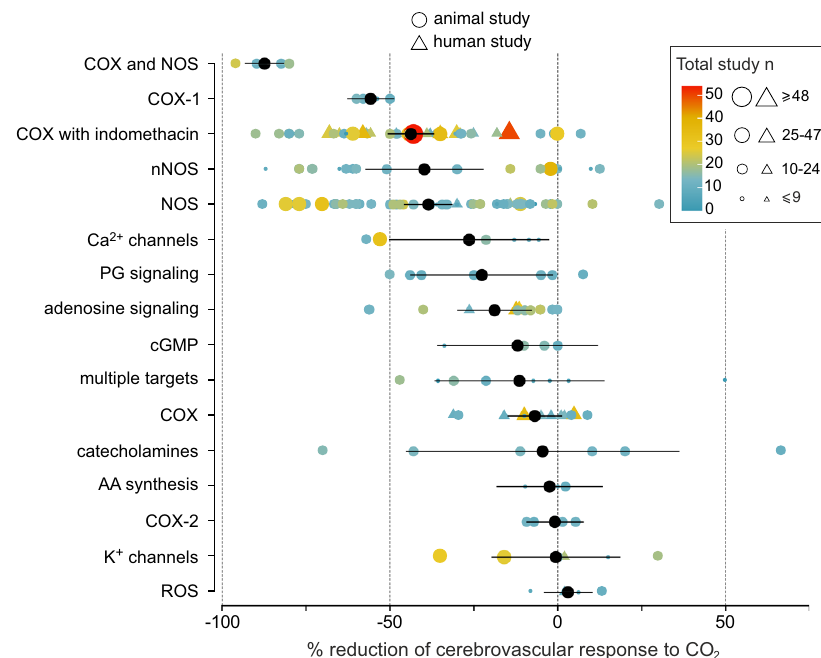
Fig. 1 Summary data illustrating the outcome of systematic review and analysis of data reported in studies that investigated the signaling mechanisms underlying the cerebrovascular response to CO 2 . Individual data points illustrate the percent reduction of the cerebrovascular response to CO 2 in conditions of pharmacological or genetic blockade of hypothesized signaling pathways, reported in published studies involving in vivo animal models and human participants. Color gradient and the size of each symbol denote the statistical power of each individual study (total study n ). Black symbols illustrate the mean (with 95% con fi dence intervals) reduction of CO 2 -induced cerebrovascular response observed under experimental conditions (214 in total, reported in 131 primary sources; Supplementary Table 1) grouped into categories of studies targeting speci fi c signaling pathways. The effects of indomethacin are analyzed and shown in a separate category as inhibition of cerebrovascular CO 2 reactivity by this drug is greater compared to that of other non-speci fi c cyclooxygenase inhibitors. Multiple category includes the results of experimental studies that targeted several signaling pathways simultaneously. COX cyclooxygenase, nNOS neuronal nitric oxide synthase, NOS nitric oxide synthase, PG prostaglandin, cGMP cyclic guanosine monophosphate, AA arachidonic acid, ROS reactive oxygen species. Source data are provided as a Source Data fi